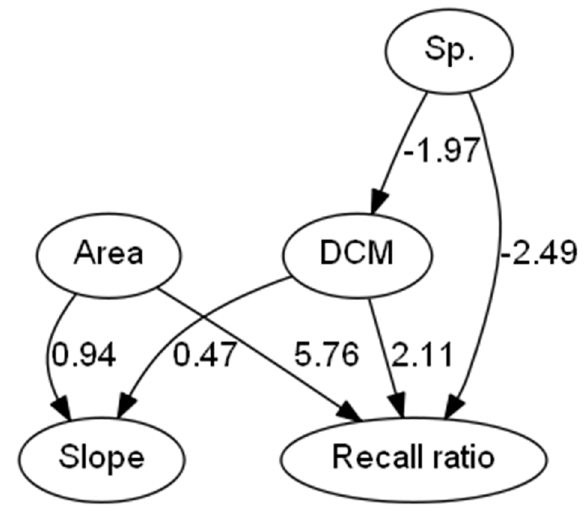
Figure 10. Structural relationships inferred by application of the DirectLiNGAM algorithm. The arrows show directions of influences and the numbers besides the arrows are the inferred values of coefficients ( 𝐁 ) of Equation (2). Positive (negative) values indicate positive (negative) effects. Higher | B | indicates a stronger relationship.